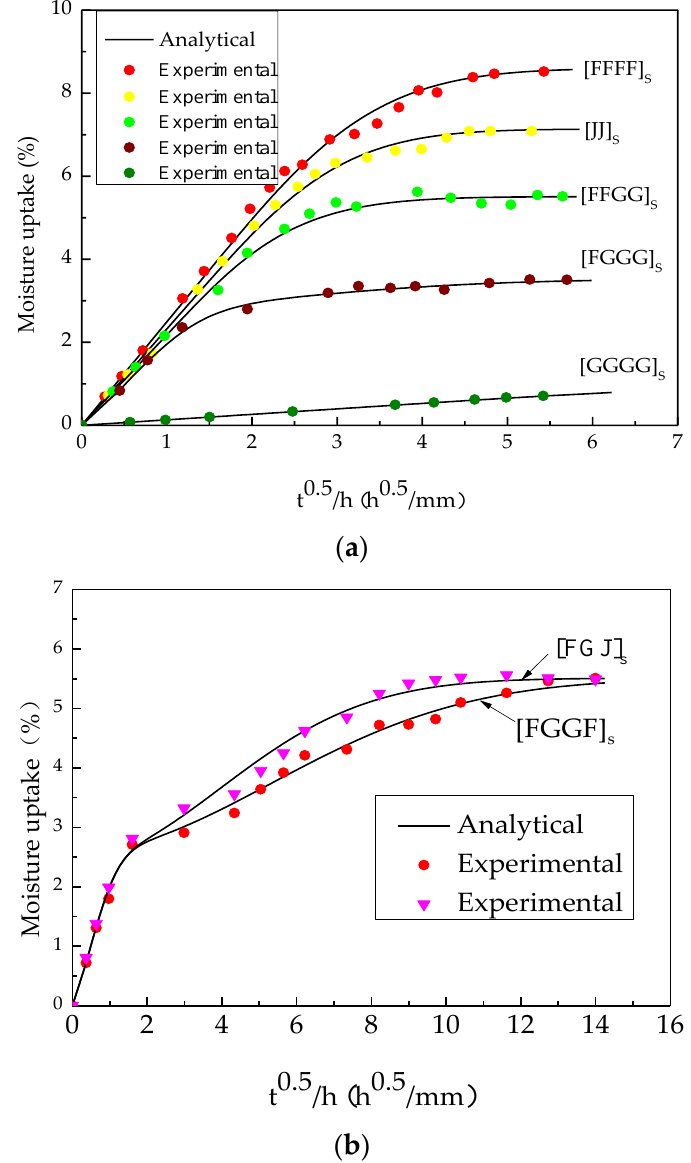
Figure 9. The details of final concentration distribution of sandwich structure: ( a ) Concentration distribution; ( b ) Normalized concentration distribution.